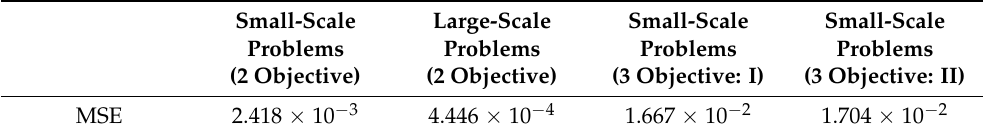
Table 10. MSE result of inverse